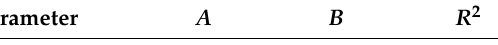
Table 7. Fitting parameters of fatigue equation.